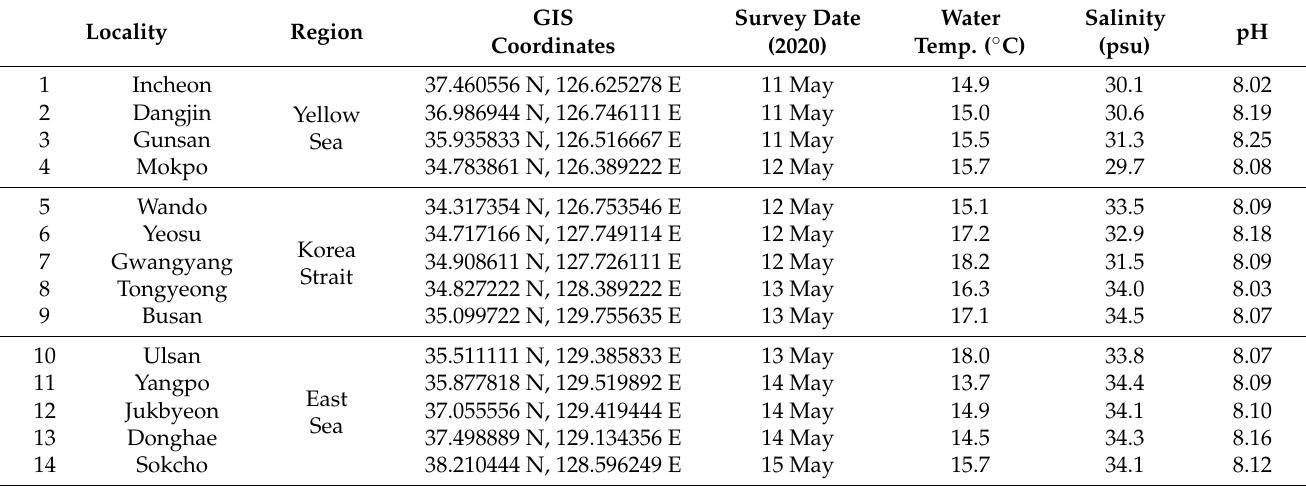
Table 1. Sampling localities and environmental information of 14 sampling sites for this